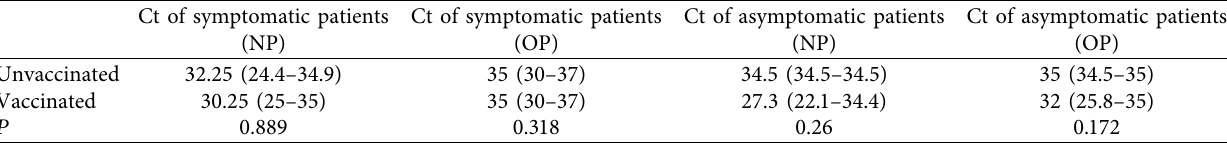
Values are expressed as median (interquartile range) Ct: cycle